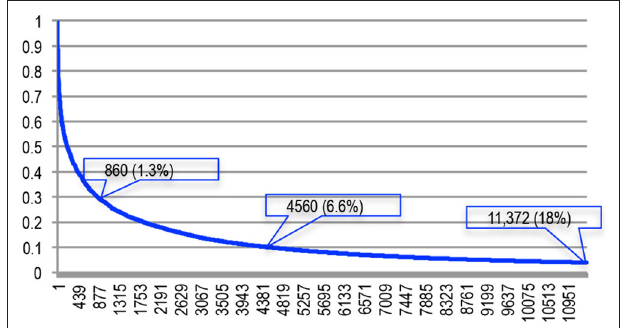
FIGURE 26 | Similarity scores of the couples detected as self-reuse/self-plagiarism.